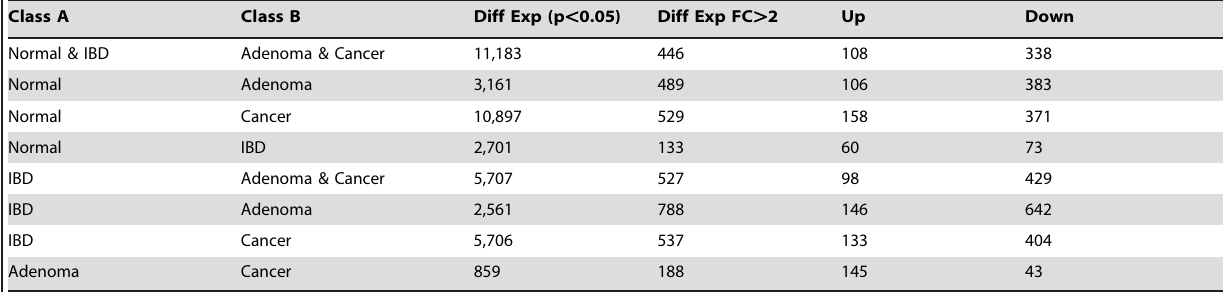
Table 1. Summary of microarray discovery